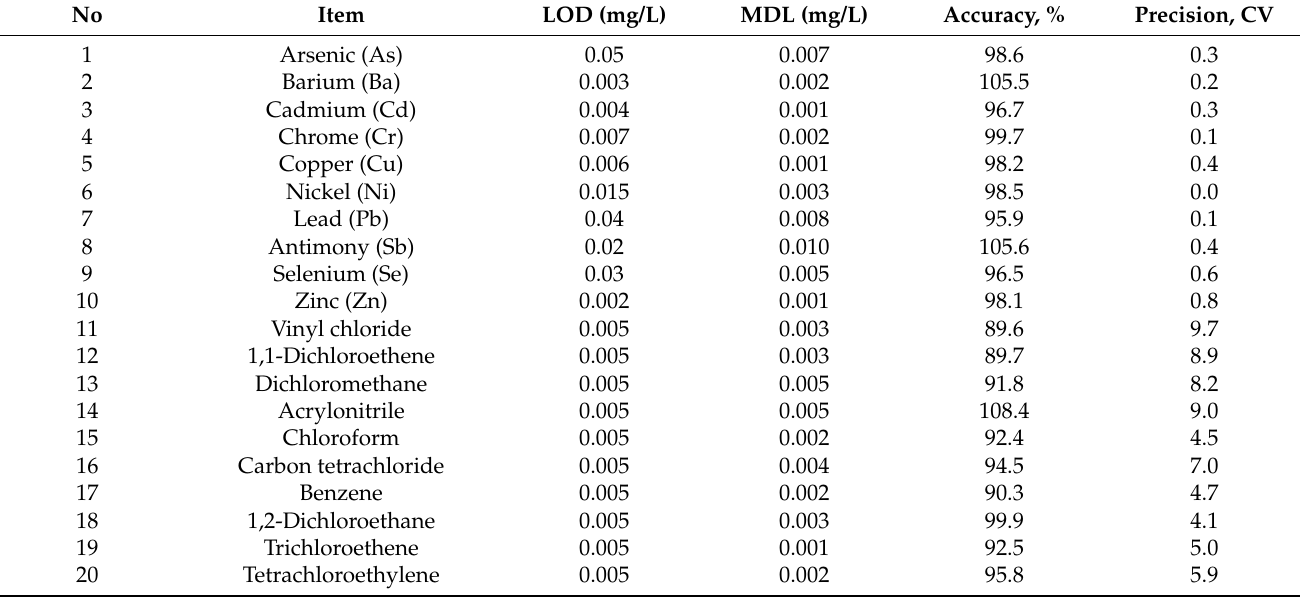
Table 3. QA/QC result of FPS laundry water quality